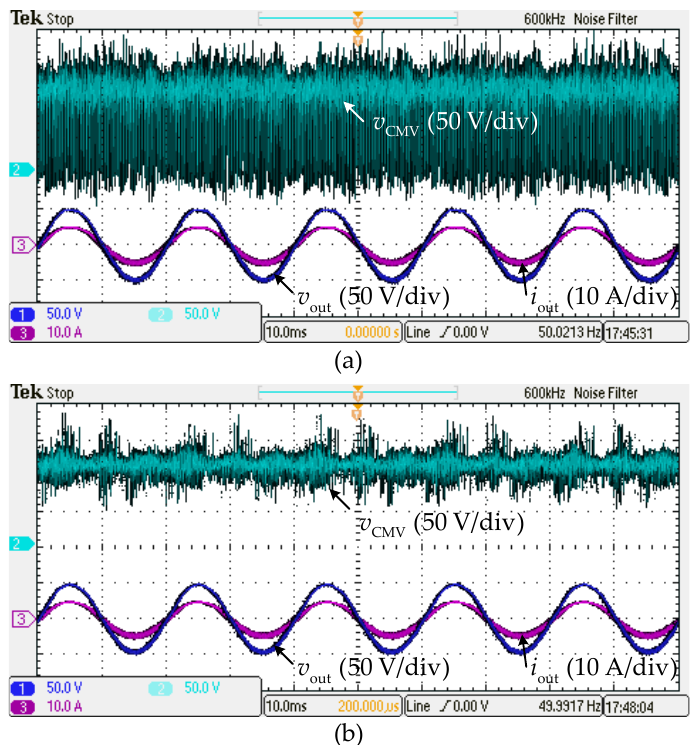
Figure 10. Experimental results of the CMV v cmv , output voltage v out and output voltage i out when the RSPWM strategy, i.e., all even vectors in this paper, is used in ( a ) the conventional three-phase qZSI system and ( b ) the modified three-phase qZSI system [Time (10